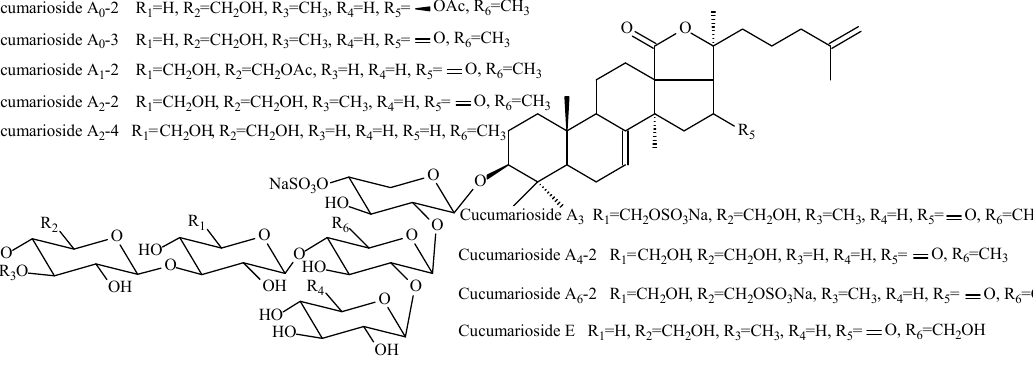
Figure 2. Structure of triterpene glycosides from the supercritical extract of C . frondosa japonica . Total compounds chromatogram of detected triterpene glycosides in negative ion mode shown in Figure 3. The figure shows that the total fraction without preliminary separation has poorly resolved peaks, and although the full qualitative composition can be determined due to the mass spectrometer detector, this does not allow quantitative analysis.